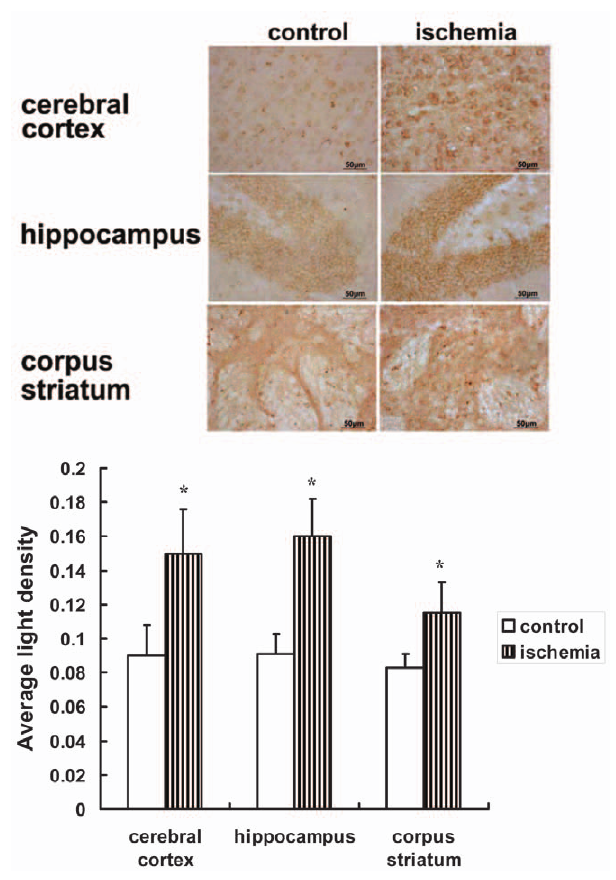
Figure 4. Positive hepcidin/pro-hepcidin staining in ischemic brain. Hepcidin/pro-hepcidin was detected by immunohistochemistry. Hepcidin/pro-hepcidin positive staining was significantly increased in cerebral cortex, hippocampus and corpus striatum of ischemic brain. The mean density of positive staining was measured by Image-Pro Plus soft. Data are presented as means 6 SEM, n= 3. *p , 0.05, vs. contralateral side.